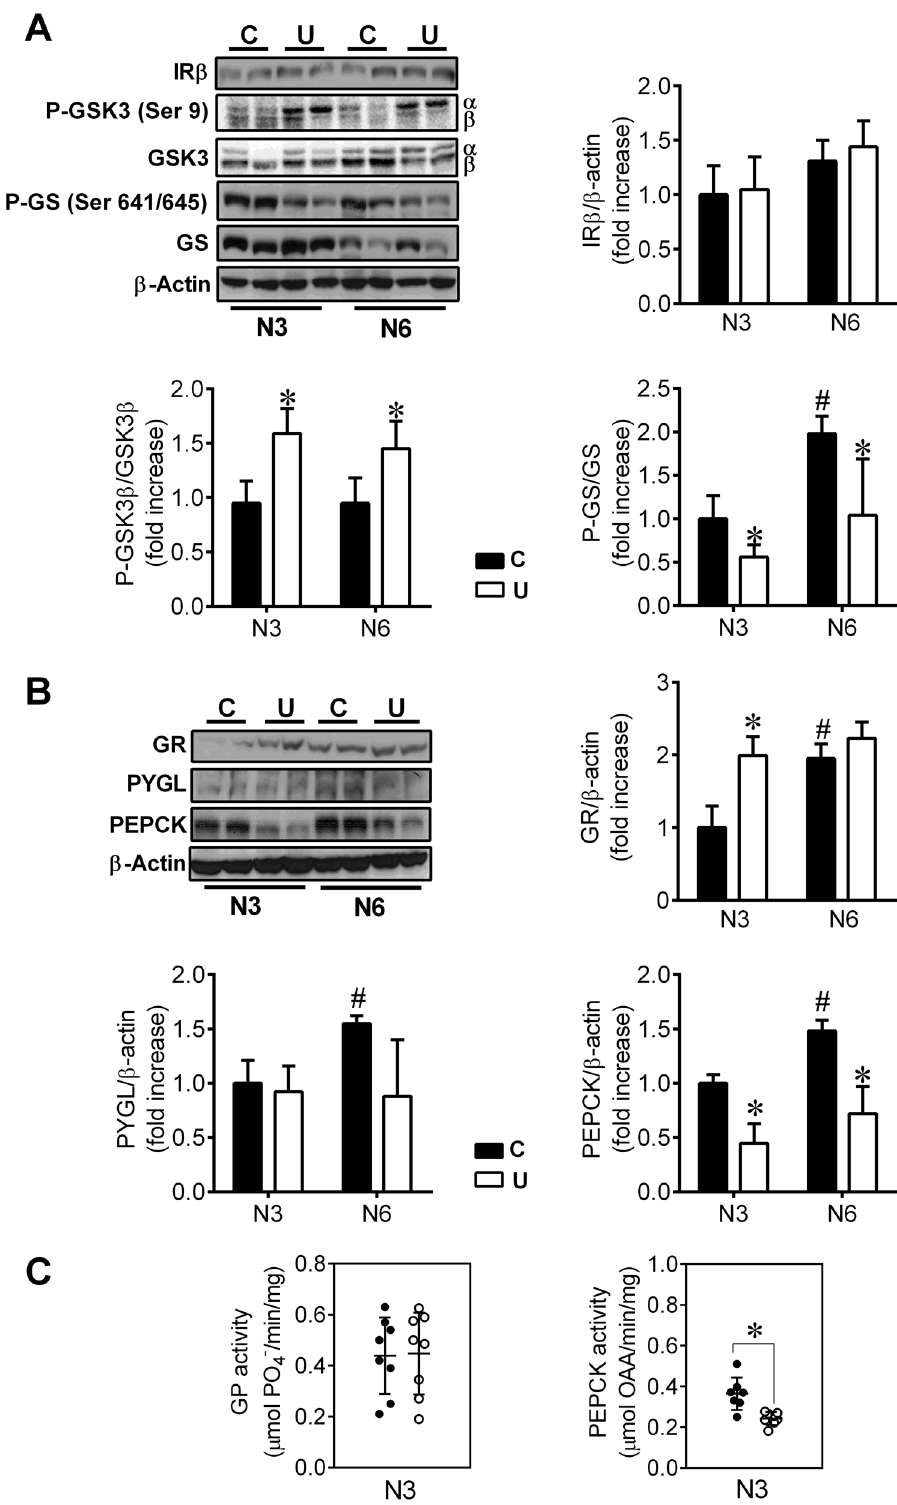
Figure 3. Regulation of hepatic levels of carbohydrate metabolism enzymes in response to postnatal fasting. ( A , B ) Activation of the pathways involved in the synthesis or degradation of glycogen was determined by immunoblotting for the indicated proteins in liver extracts from neonates after 3 or 6 h of fasting (N3 and N6, respectively). Representative blots are shown. Bars represent the densitometric quantification of all blots relative to β-actin protein levels with 6 animals per group. All values are mean ± SD. * p < 0.05 U versus C neonates at the same time point. # p < 0.05 N6 versus N3 within the same nutritional condition. ( C ) Enzymatic activities of the liver isoform of glycogen phosphorylase (PYGL) and phosphoenol pyruvate carboxy kinase (PEPCK) from C and U neonates at N3, n = 8. All values are mean ± SD. * p < 0.05 U versus C